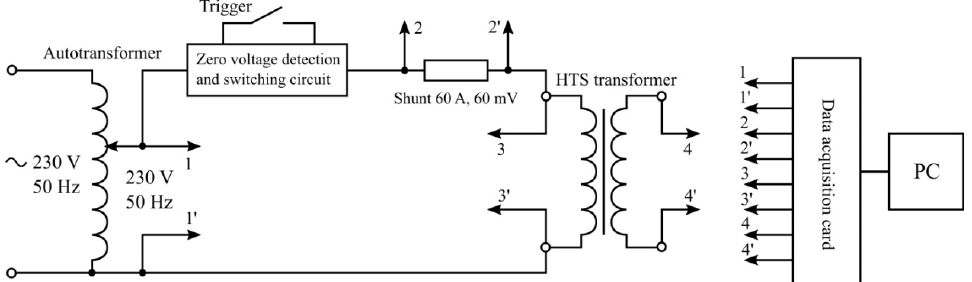
Figure 11. Structure of SCS tape made by SuperPower Inc.: 1—copper, 2—silver, 3—(Re)BCO, 4—Buffer zone, 5—Hastelloy, 6—silver, 7—copper.